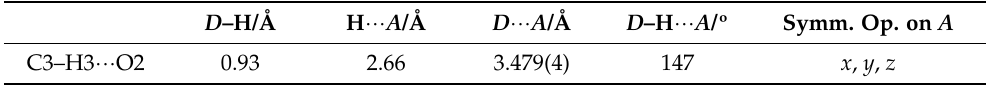
Table 1. Geometric parameters of hydrogen bonds determined from geometric analysis (A represent the hydrogen bond acceptor; Symm. Op. On A means Symmetry operation on A).